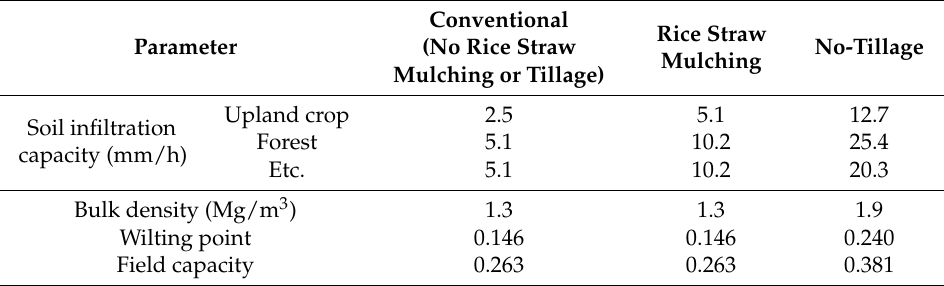
Table 4. Parameter values for the soil bulk density (BD) and infiltration capacity (INFILT) for the rice straw mulching and no-tillage